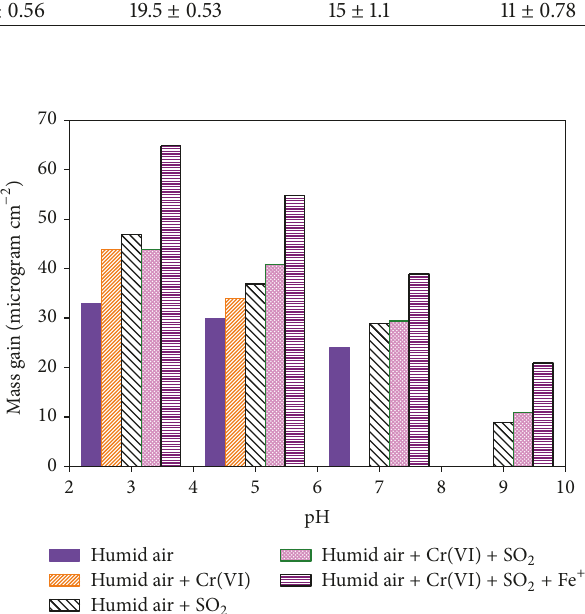
Figure 5: Total mass gain ( 𝜇 g cm −2 ) and corresponding conditions as a function of pH of the scratched iron roof materials after 60 days of